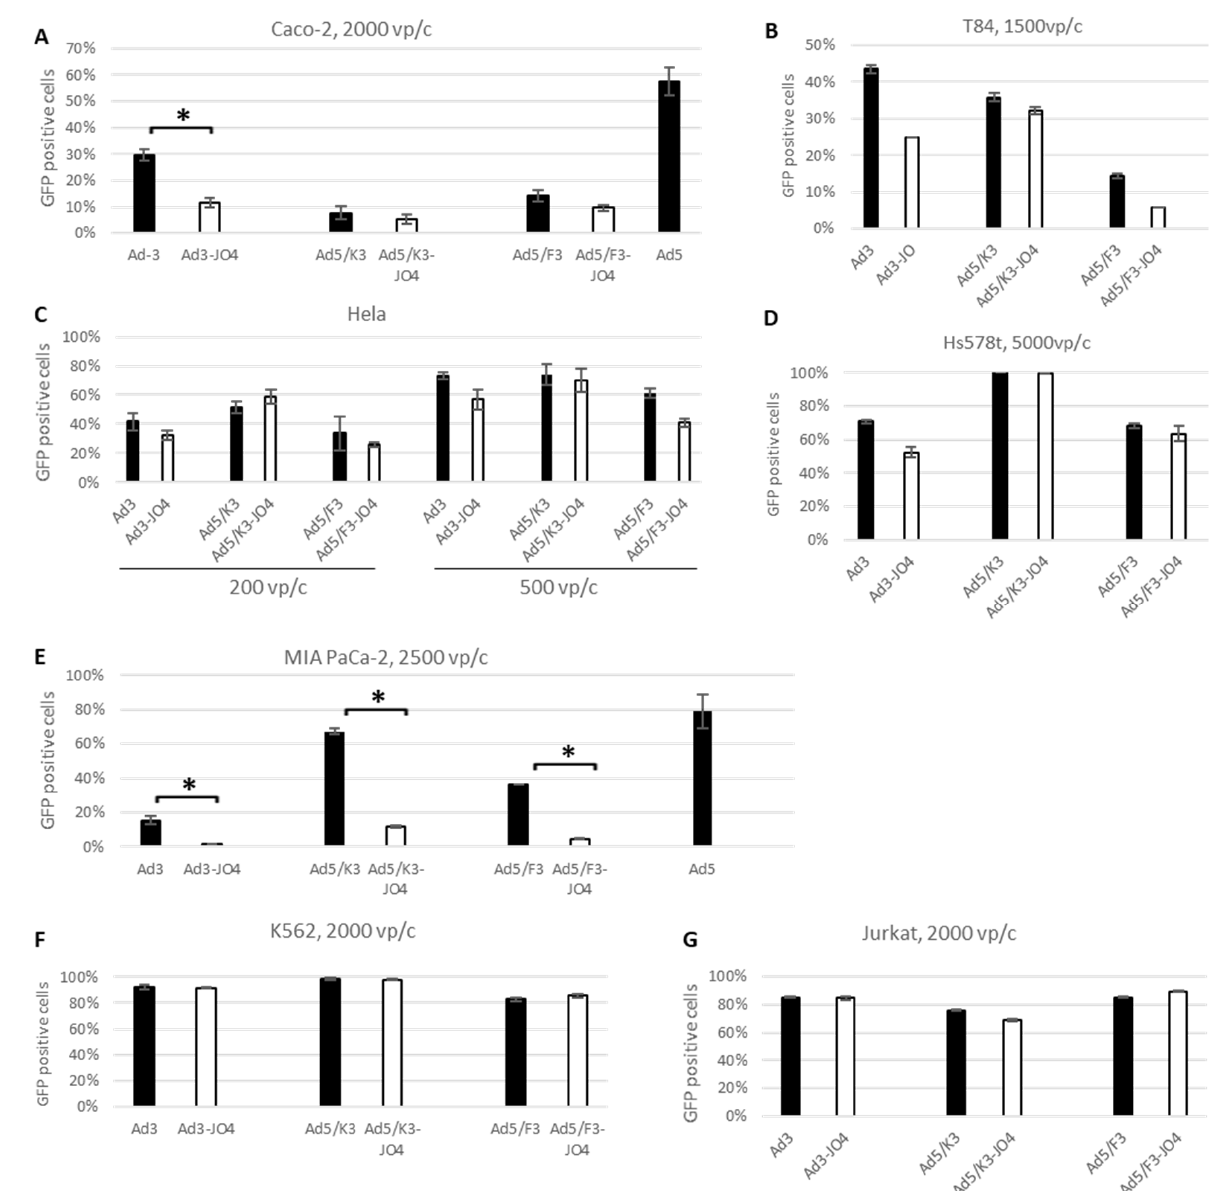
Figure 2. Transgene expression in tumor cell lines with different DSG2 levels. ( A ) Colorectal adenocarcinoma-derived Caco-2 cell line with ~75% DSG2 positive cells. ( B ) Colorectal carcinoma- derived T84 cell line with ~75% DSG2 positive cells. ( C ) Cervical adenocarcinoma-derived Hela cell line with ~100% DSG2. ( D ) Breast carcinoma-derived Hs578T cell line with ~97% DSG2. ( E ) Pancreas carcinoma-derived MIA PaCa-2 cell line with 0.2% DSG2. ( F ) Chronic myeloid leukemia-derived K562 cell line with high DSG2 (85%, Table 1). ( G ) Acute T cell leukemia-derived Jurkat cell line with